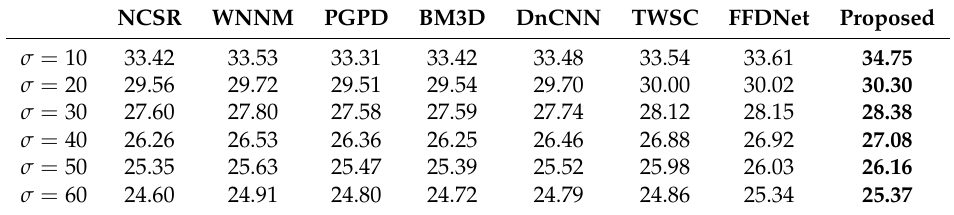
Table 5. Average PSNRs (dB) of the competing methods obtained for 50 images selected from the BSD dataset with noise level σ = 10, 20, 30, 40, 50 and 60.